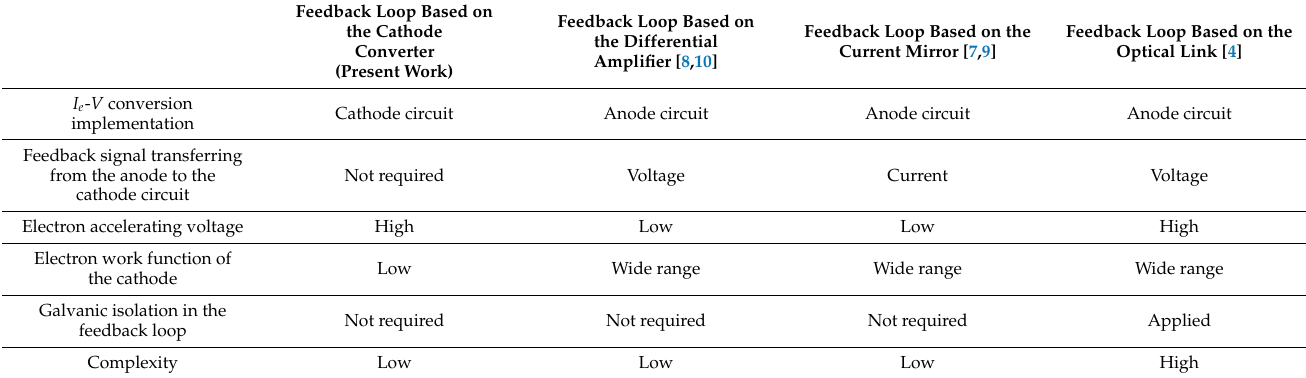
Table 2. Comparison of feedback loop applications used in emission current